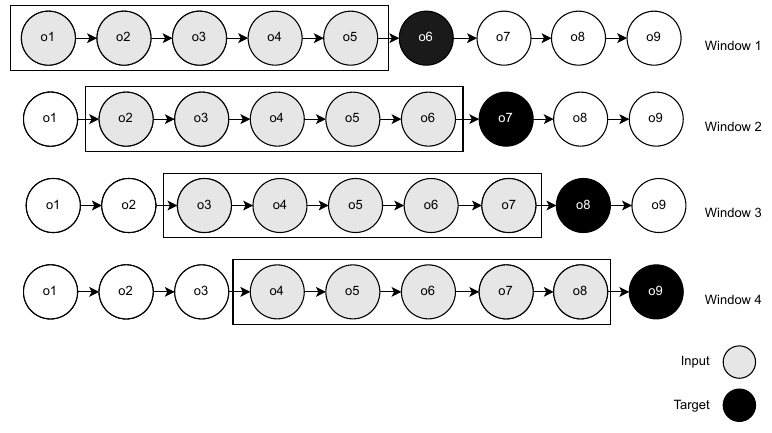
Figure 6. Sliding window